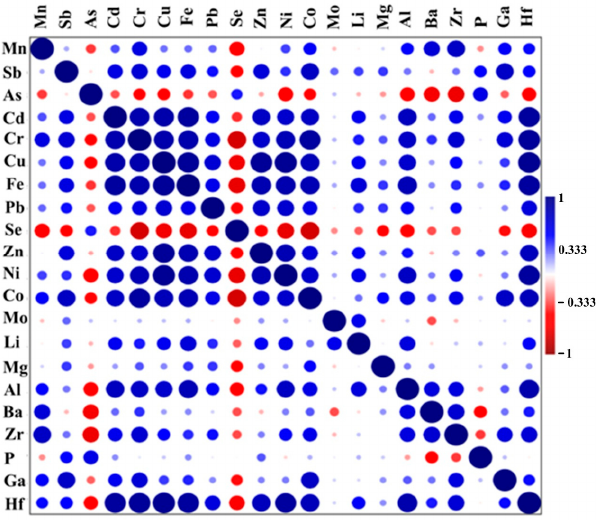
Figure 4. Pearson correlation matrix of heavy metals in surface sediments. For colour, blue colour means positive correlation and red colour means negative correlation. The size of the circle refers to the degree of correlation.